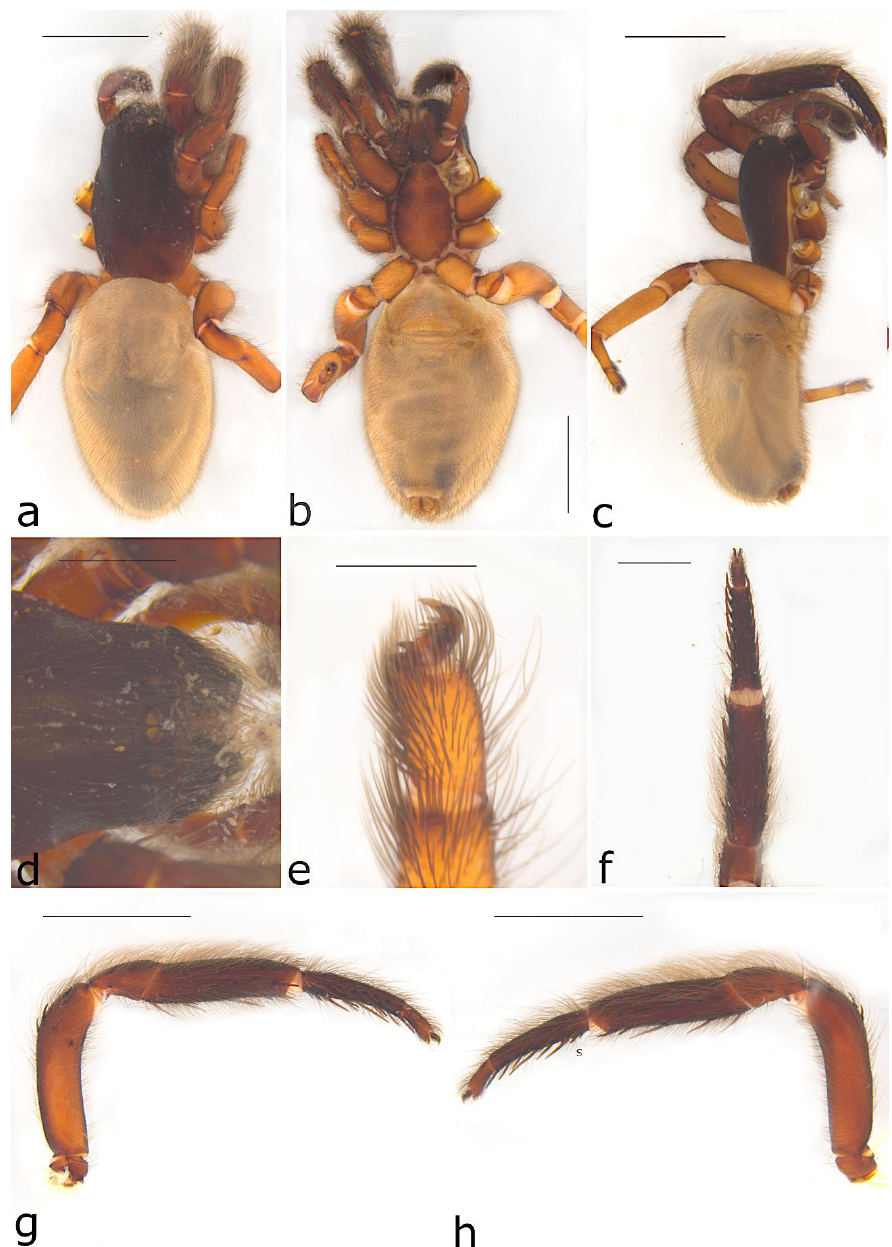
Figure 48. Ariadna propria sp. nov. ♀ paratype (SAMA NN31205) from Melrose (SA): ( a ) habitus, dorsal view; ( b ) same, ventral view; ( c ) same, lateral view; ( d ) eyes, dorsal view; ( e ) left metatarsus IV, preening comb, retrolateral view; ( f ) left leg I, ventral view; ( g ) same, prolateral view; ( h ) same, retrolateral view; cluster of macrosetae indicated by arrow. Scale bars ( a – c ) = 2 mm, ( d ) = 1 mm, ( e ) = 0.5 mm, ( f ) = 1 mm and ( g , h ) = 2 mm.